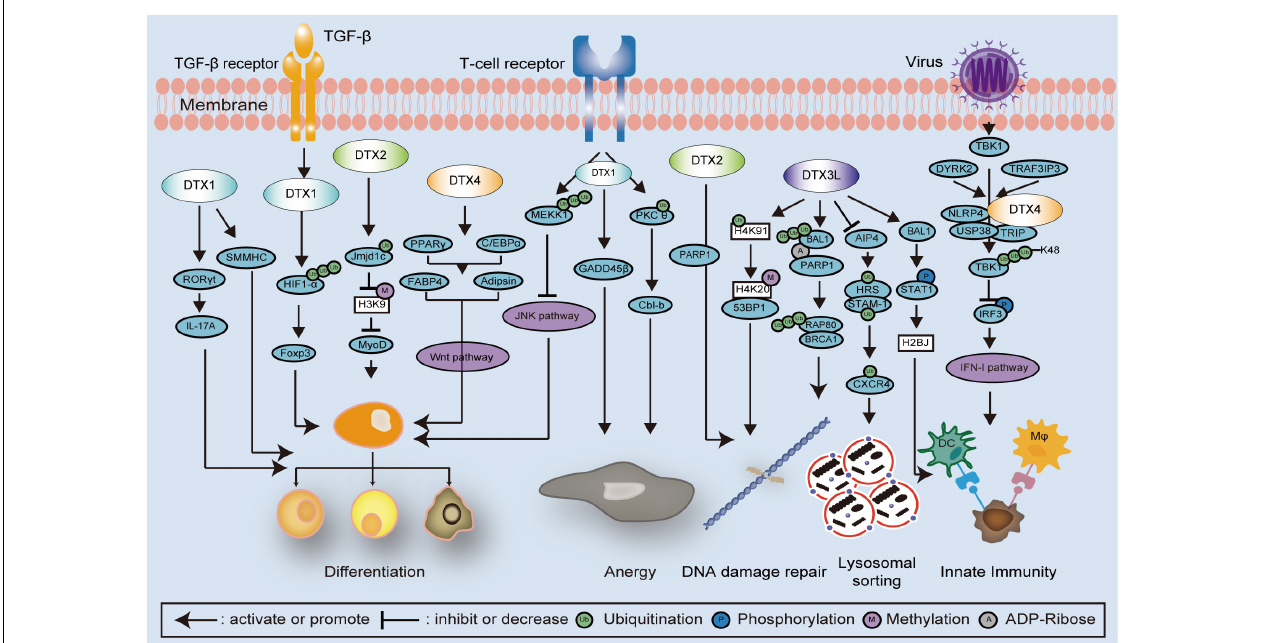
FIGURE 3 | Schematic diagram showing DTX family related signaling pathways and interactions in cell development. DTX family proteins regulate cell differentiation via several mechanisms and signaling pathways, such as poly-ubiquitination of HIF1- α and MEKK1, monoubiquitination of Jmjd1c, methylation of histones, and JNK and Wnt signaling pathways. In the regulation of cell anergy, the T cell receptor is activated and monoubiquitination of PKC θ is induced by DTX1, following the alteration of GADD45 β and Cbl-b expression. In the regulation of DNA damage repair, DTX3L promotes the polyubiquitination of the RAP80-BRCA1 complex, monoubiquitination of histones, and STAT1phosphorylation. The combination of DTX2 and PARP1 is also involved with the regulation of DNA damage repair. Upon viral infection, TBK1 is phosphorylated thereby activating the IFN-I pathway. The DTX4, NLRP4, USP38, and TRIP complex inhibits the IFN-I pathway via enhancing polyubiquitination of TBK1, which is also associated with DYRK2 and TRAF3IP3. STAT1, signal transducer and activator of transcription 1; PARP1, Poly (ADP-Ribose) Polymerase 1; HIF1- α , hypoxia inducible factor 1 subunit alpha; MEKK1, mitogen activated protein kinase/ERK kinase 1; Jmjd1c, Jumonji domain containing 1c; JNK, Jun N-terminal Kinase; PKC θ , protein kinase C θ ; GADD45 β , growth arrest and DNA damage inducible 45 beta; Cbl-b, Casitas B-lineage lymphoma-b; RAP80, receptor associated protein 80; BRCA1, Breast Cancer 1; TBK1, TANK binding kinase 1; NLRP4, nod-like receptor (NLR) family pyrin